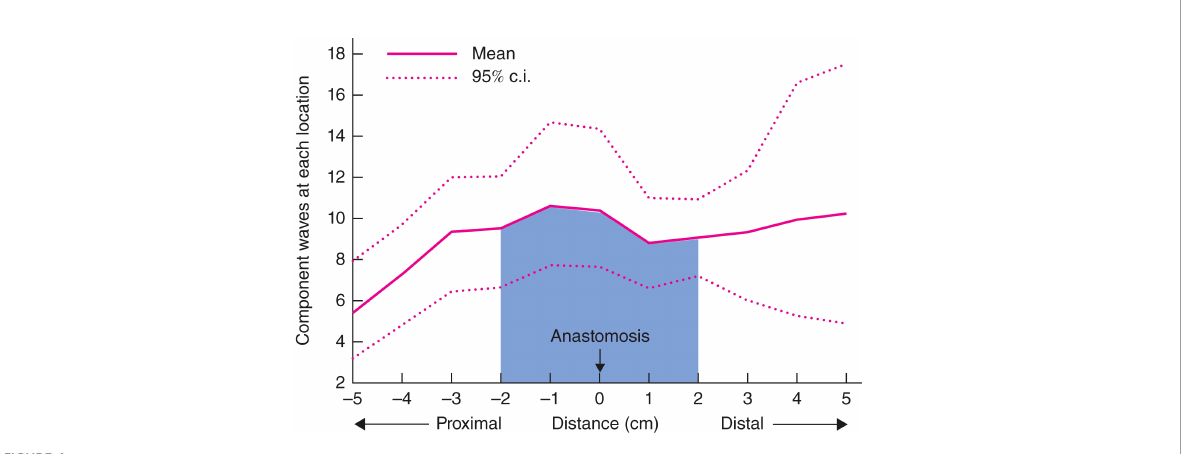
FIGURE 4 Adapted from Vather et al., 2016 with permission. Density analysis mapping of the number of propagating events occurring within 5 cm of the anastomosis. Some 47% of all propagating contractions occurred within 2 cm of the anastomosis (shaded area), with no drop-off at the site of the